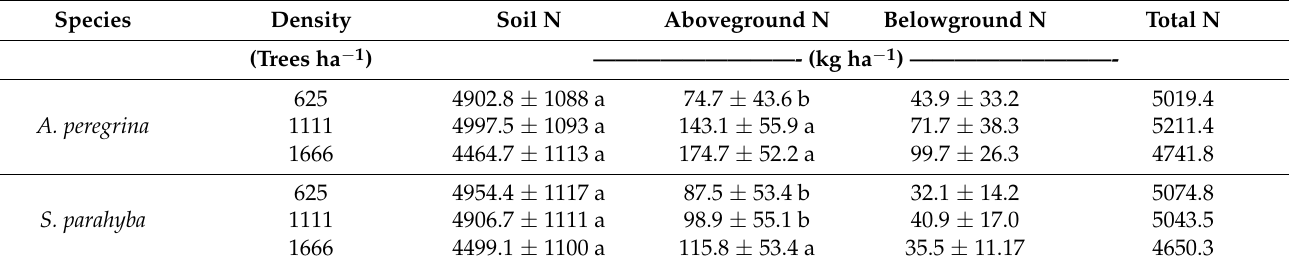
Table 1. Mean values ( ± standard deviation) of N pools (kg ha − 1 ) at 0–20 cm soil depth, and in aboveground and belowground biomass of A. peregrina and S. parahyba at the three stand densities. For a given species, different letters indicate statistical differences between stand density.